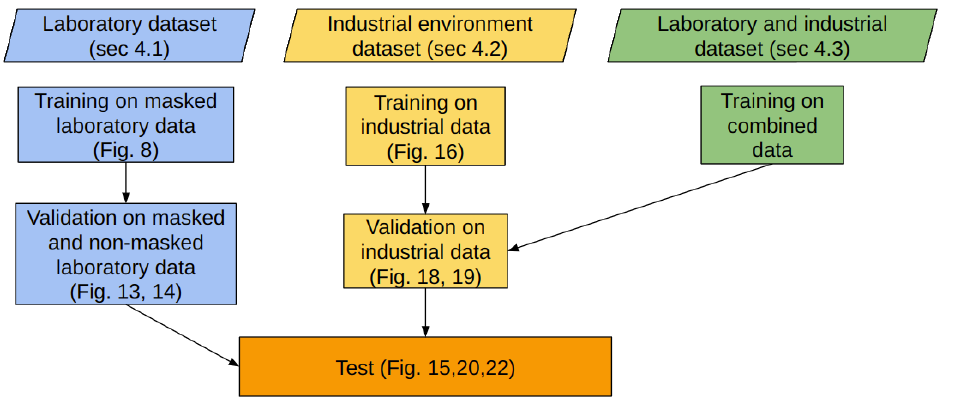
Figure 6. Workflow of the performed experiments, including the training, validation, and testing steps for the three models trained in the laboratory ( blue ), in the real environment ( yellow ) and in a combination of the laboratory and real environment ( green ) data. In the parentheses the respective sections and figures are cited.